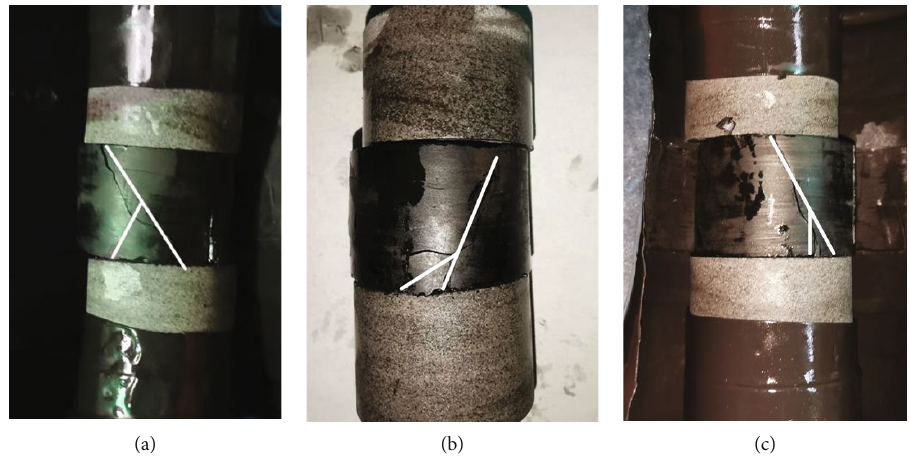
σ - t experimental curve of sample 1 # when the ave -